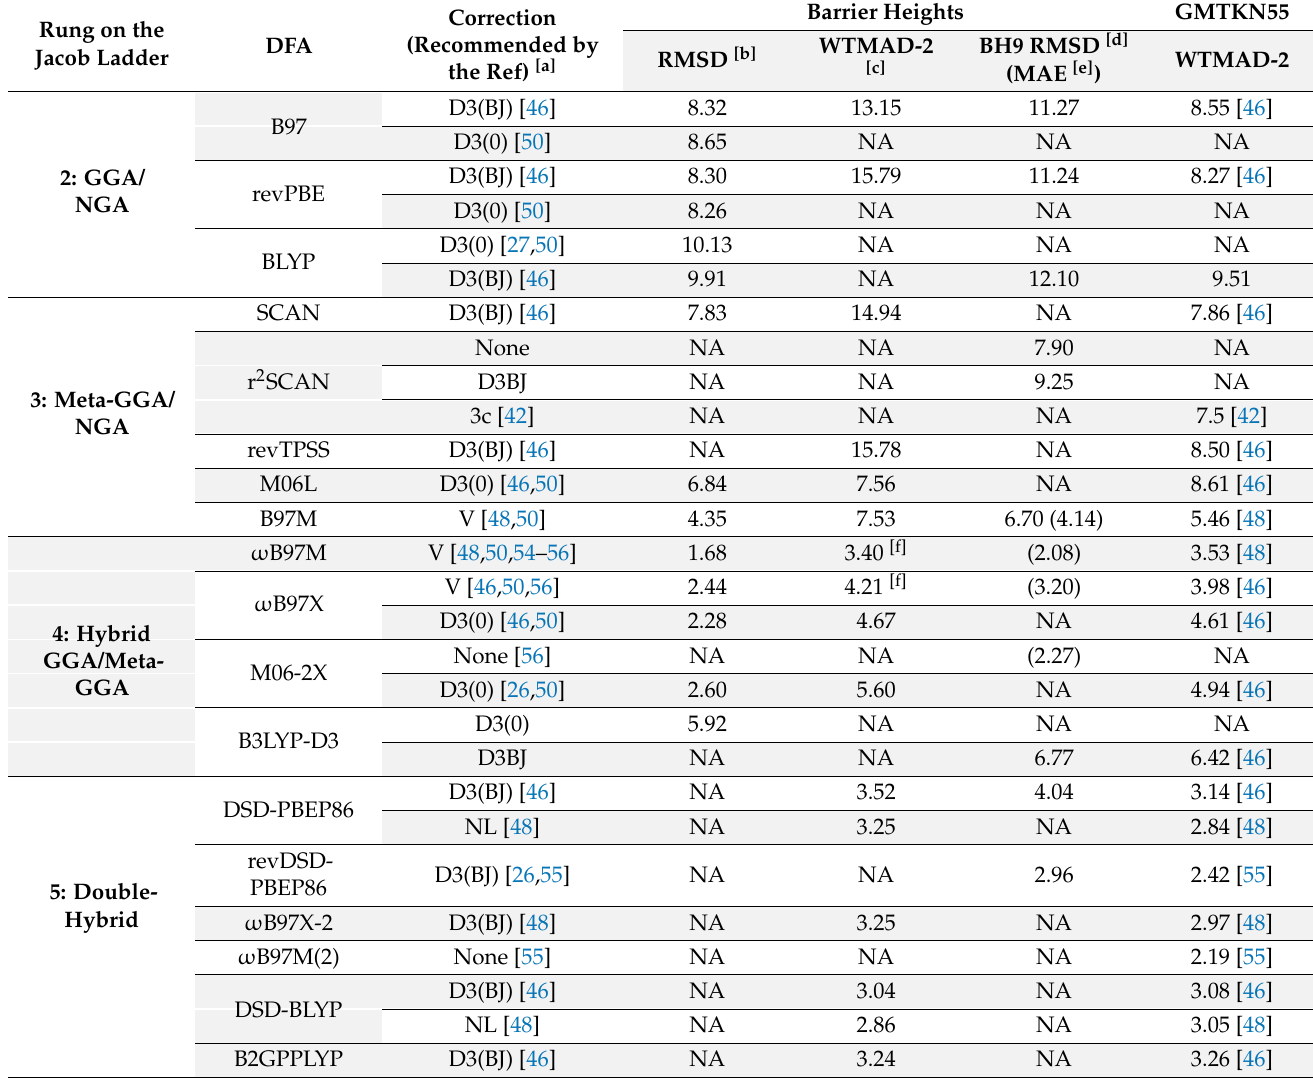
Table 1. Selected compilation of recommended DFAs at various rungs of the DFA Jacob’s ladder and their associated deviations in gas phase benchmark for barrier heights and noncovalent